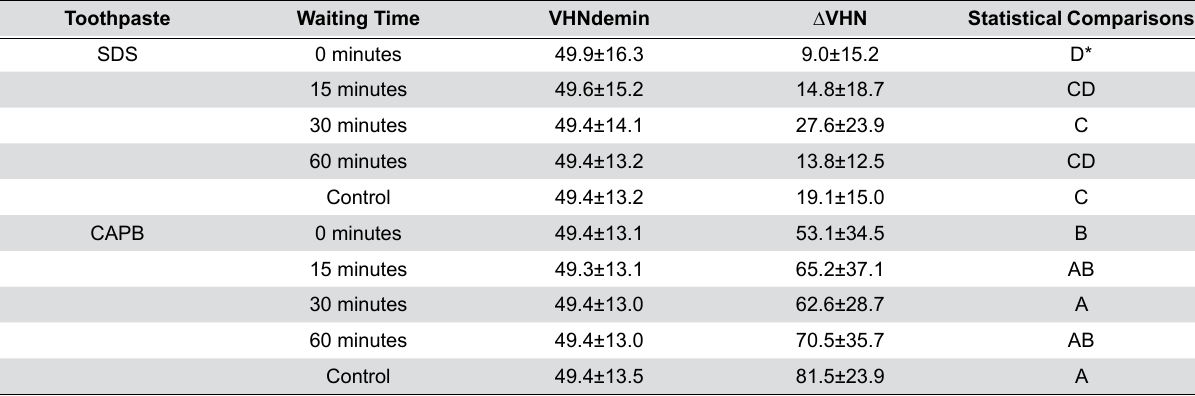
Table 1- Microhardness data (mean±standard deviation) and results of the statistical